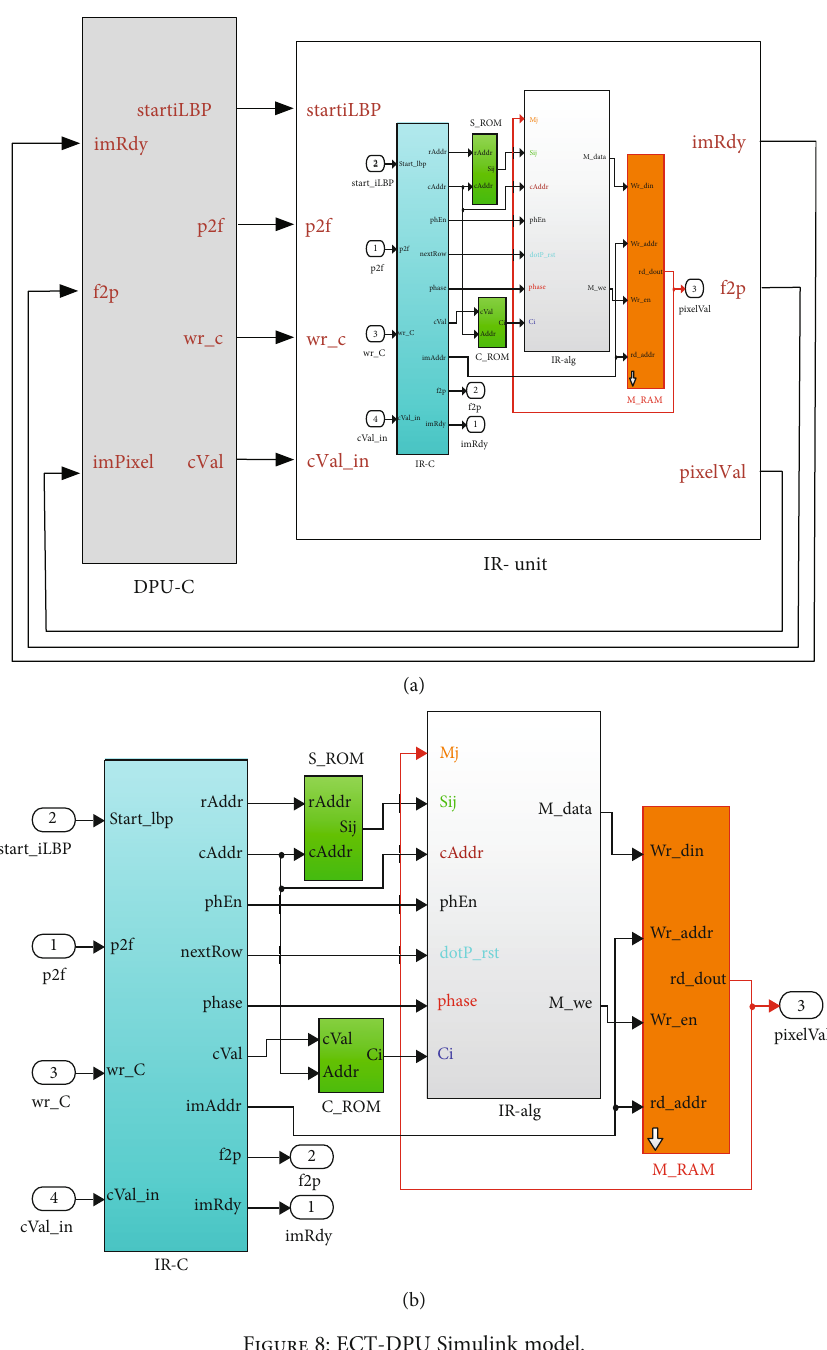
Figure 8: ECT-DPU Simulink